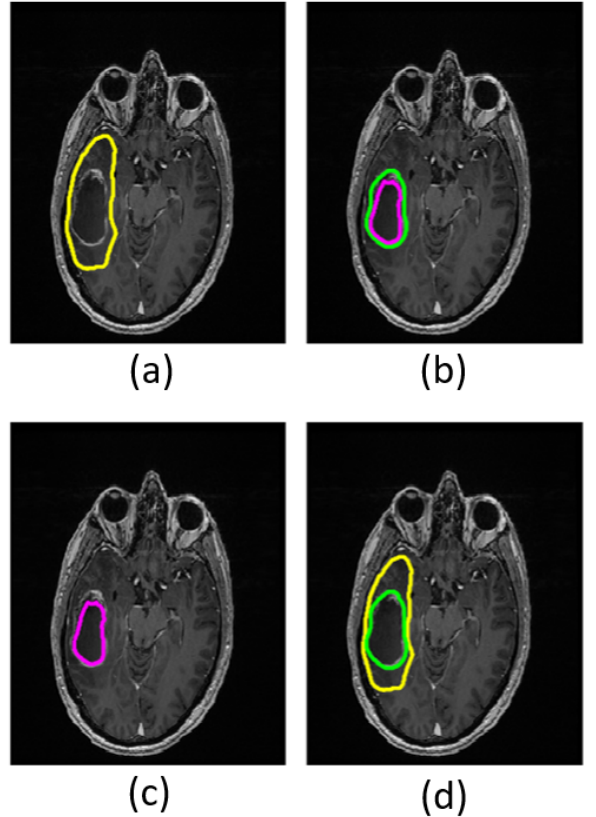
Figure 1. Masks in a grade IV patient overlaid on structural T 1 w images. The yellow boundary shows the total tumor region ( a ); the area between the green and purple boundaries shows the enhancing tumor region ( b ); the area within the purple boundary shows necrotic tumor region ( c ); and the area between the yellow and green boundaries shows the non ‐ enhancing tumor region ( d) .